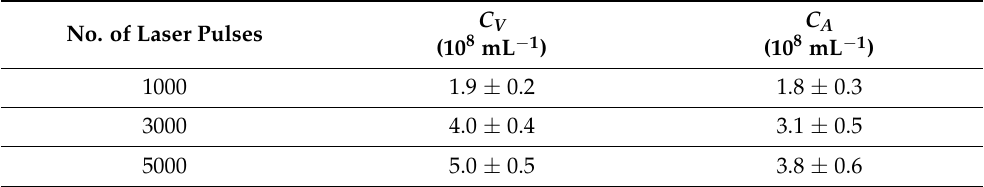
Table 1. TiO 2 concentrations calculated from the crater volume ( C V ) or from the Beer–Lambert law ( C A ) per number of